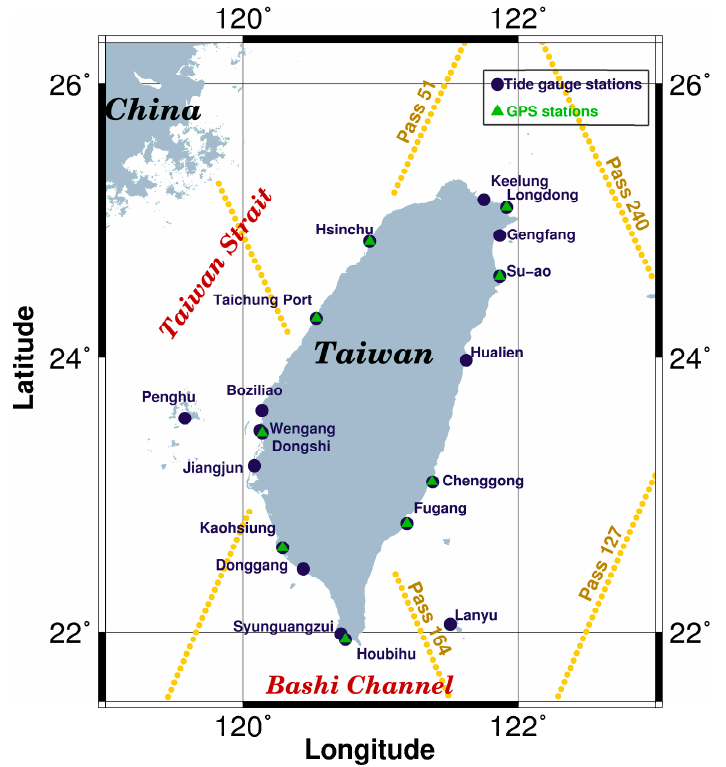
Figure 1. Location of tide gauges (blue circle), global positioning system (GPS) stations (green triangle), and TOPEX/Poseidon ground tracks (yellow dotted line) used in this study.